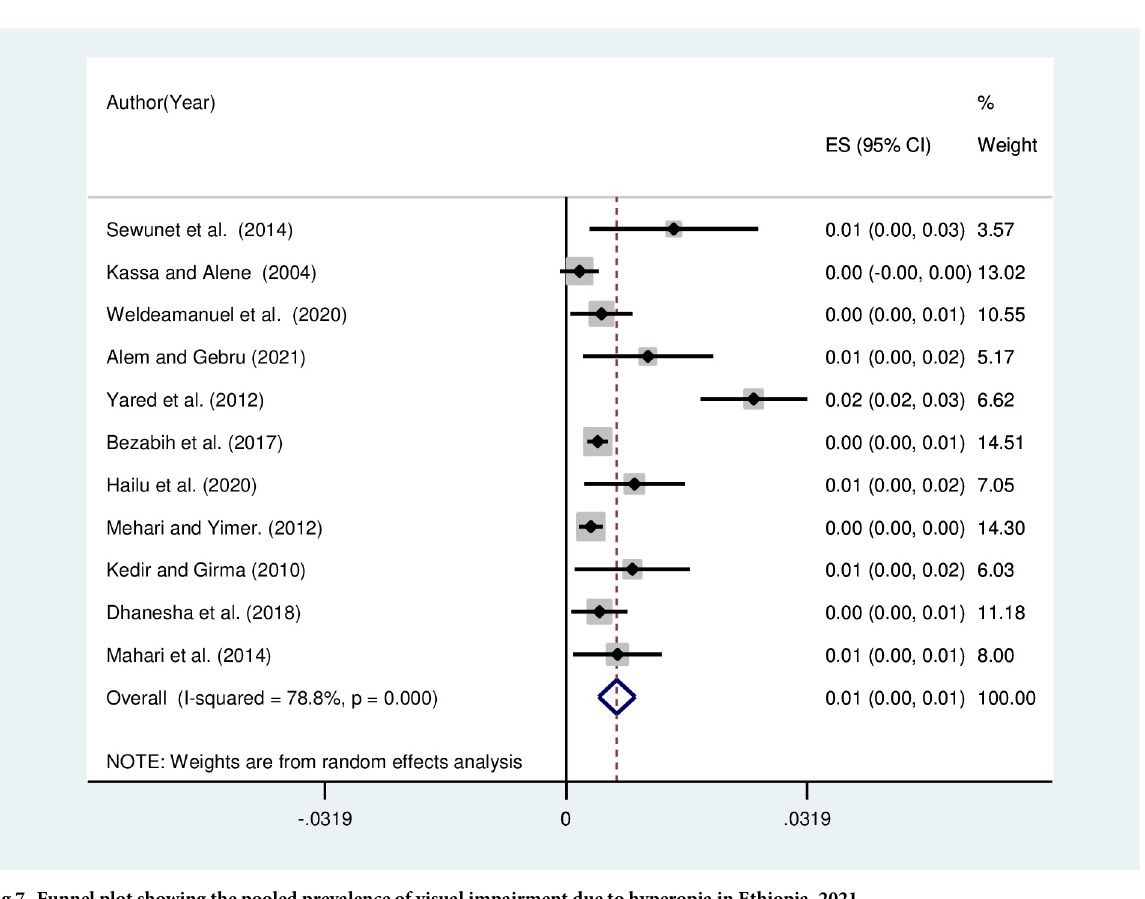
Fig 7. Funnel plot showing the pooled prevalence of visual impairment due to hyperopia in Ethiopia, 2021.